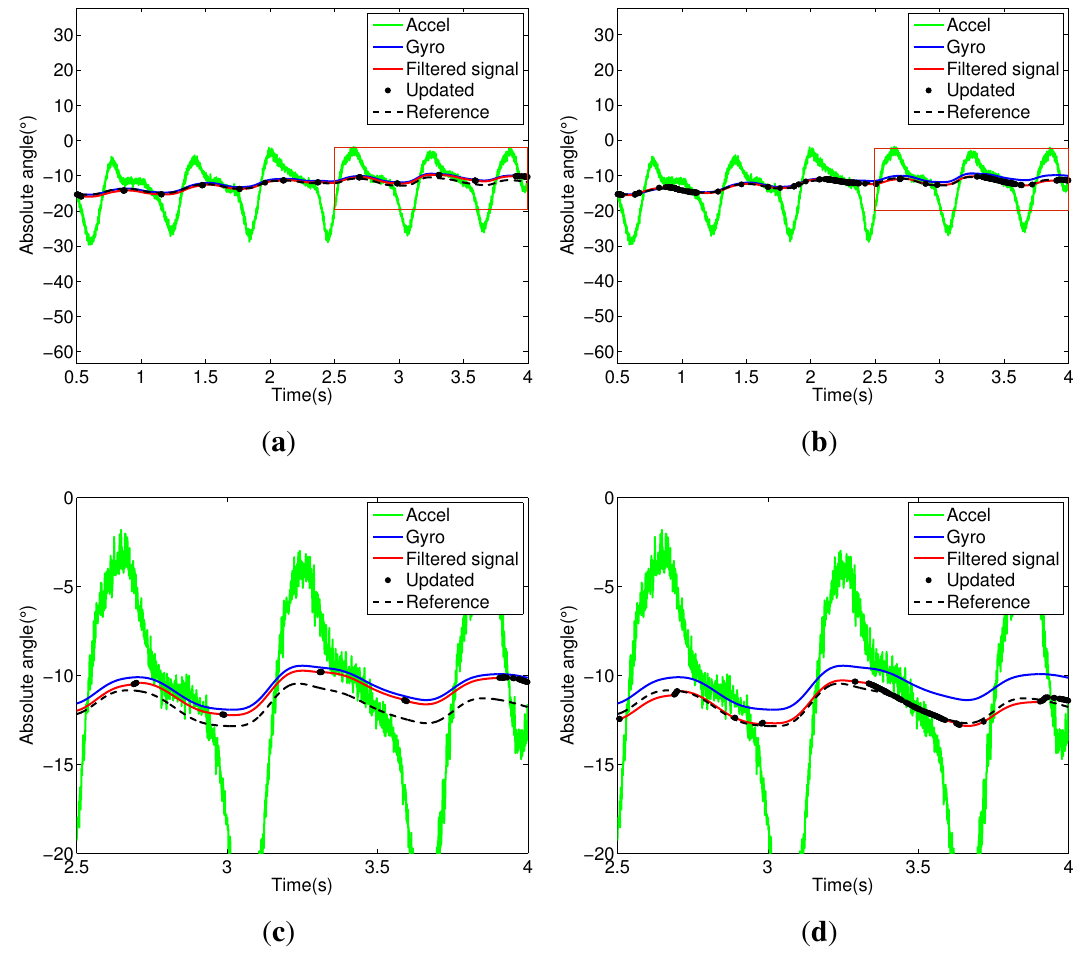
Figure 5. Body/trunk segment. ( a ) Kalman filter (KF) signals; ( b ) Markov KF